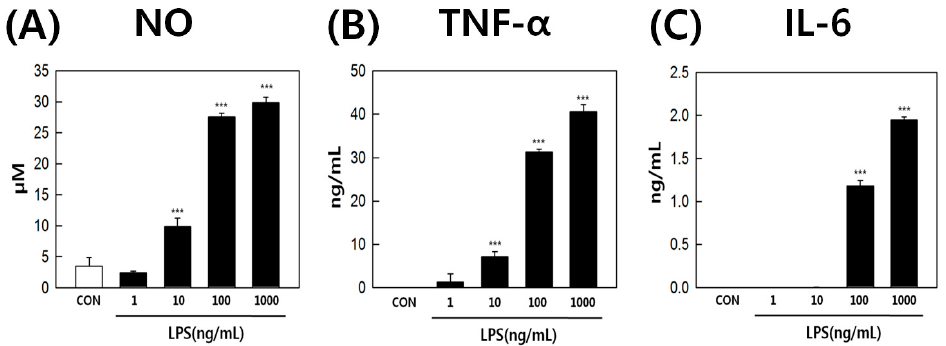
Figure 3. ( A ) nitric oxide (NO); ( B ) tumor necrosis factor- α (TNF- α ); and ( C ) interleukin-6 (IL-6) production by RAW264.7 cells treated with 0, 1, 10, 100, and 1000 ng/mL LPS. *** p value < 0.001.